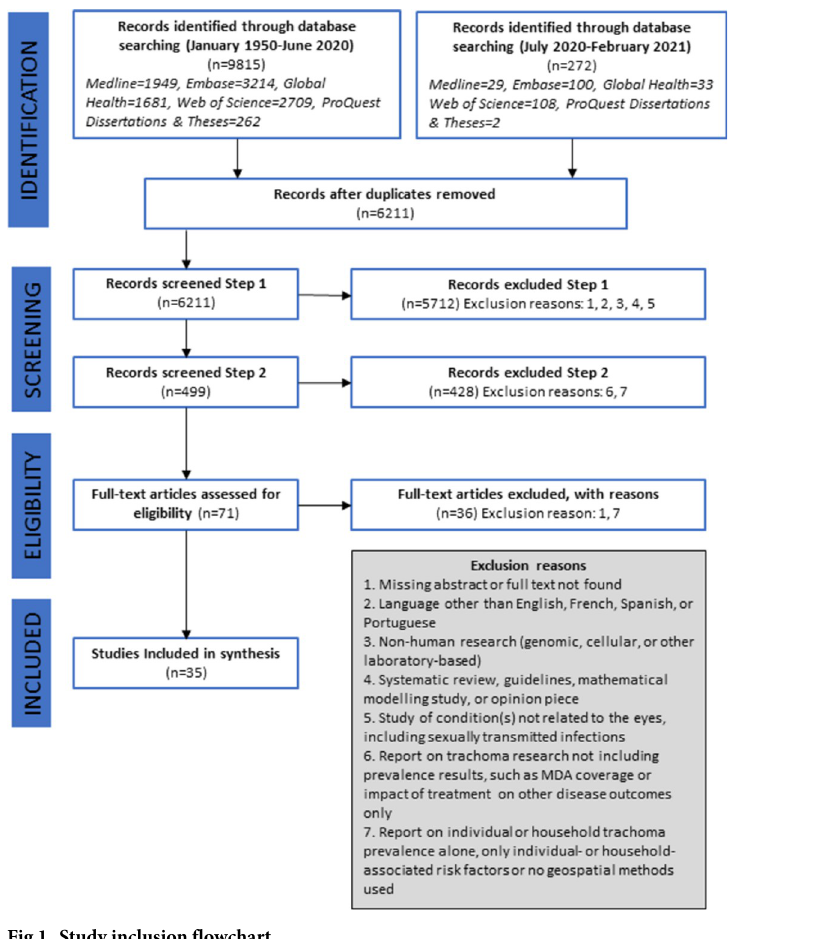
Fig 1. Study inclusion